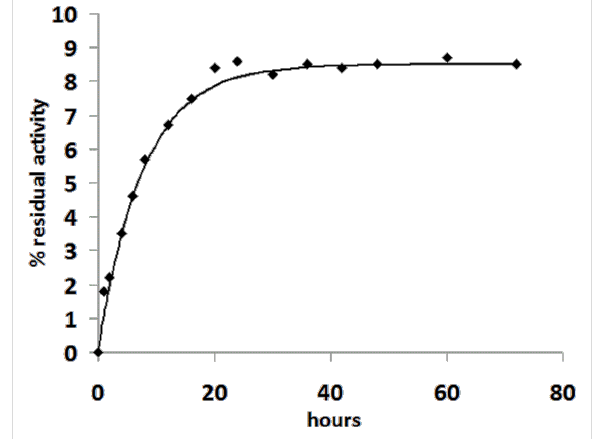
Figure 3: Recovery of activity for ZmPDC inhibited by furan 17 (1.0 µM) and then incubated with ThDP (1.0 mM). The activity is given as a percentage of the initial activity of uninhibited